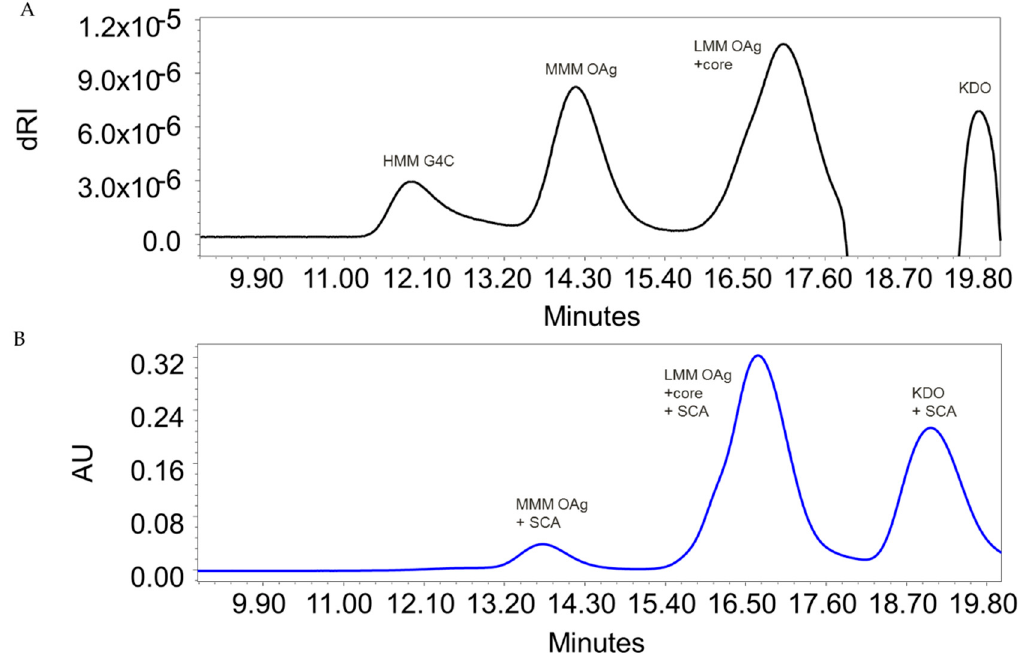
Figure 1. HPLC–SEC profiles of sugar extracted from S. flexneri 6 ∆ tolR GMMA: ( A ) detection by refractive index and ( B ) detection at 252 nm after sugar derivatization with semicarbazide (SCA). Similar profiles were obtained for sugar extracted from all the wild-type strains analyzed (Table 1). Table 3. All Shigella flexneri 6 wild-type strains analyzed display HMM G4C and MMM OAg of similar average size and relative amount compared to the corresponding OMV. Average MM (KDa) and relative % * of HMM G4C and MMM OAg Strains Bacteria OMV HMM G4C MMM OAg HMM G4C MMM